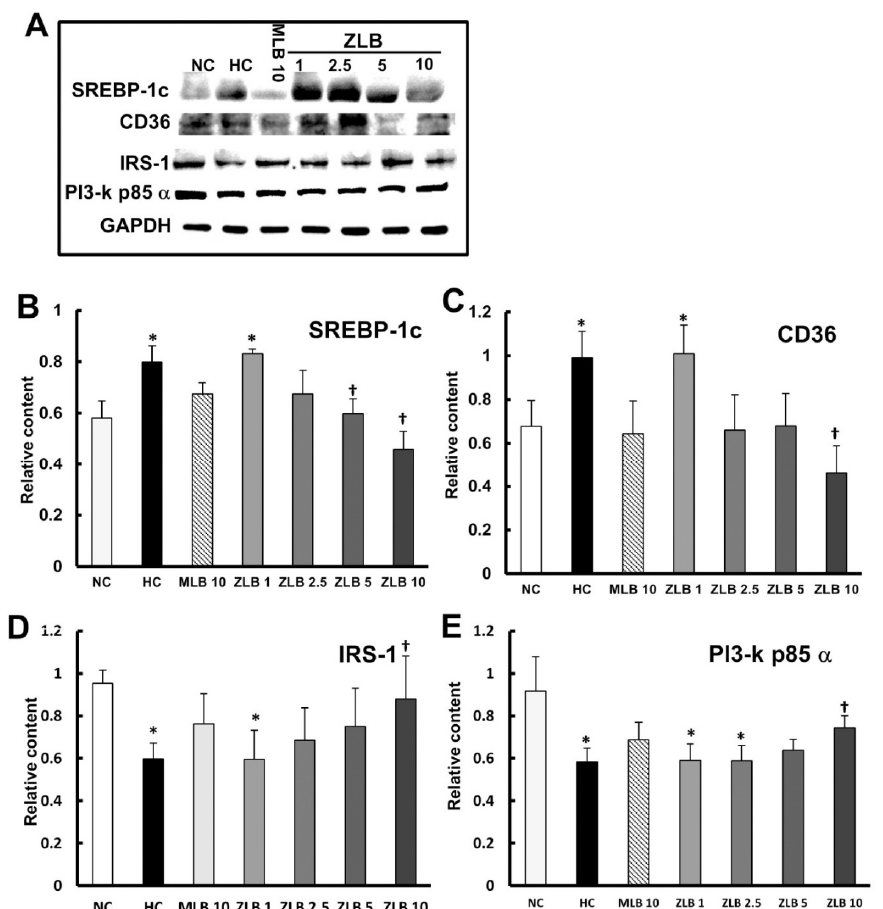
Figure 6. Effects of MLB and ZLB on intracellular signaling in metabolism. Marker proteins for liver lipid and glucose metabolism were detected by Western blotting ( A ). GAPDH was used as an internal standard. The blots of SREBP1c ( B ), CD36 ( C ), IRS-1 ( D ), and PI3-kp85 α ( E ) are calculated and shown in the bar chart. NC, normal diet control; HC, high-fat-diet (HFD) control; MLB10, HFD with 10 mg/kg/day of MLB; ZLB1, ZLB2.5, ZLB5, and ZLB10, HFD with 1, 2.5, 5, and 10 mg/kg/day of ZLB. Values are expressed as mean ± SD (n = 6 per group). * P < 0.05 vs. NC group and † P < 0.05 vs. HC group.